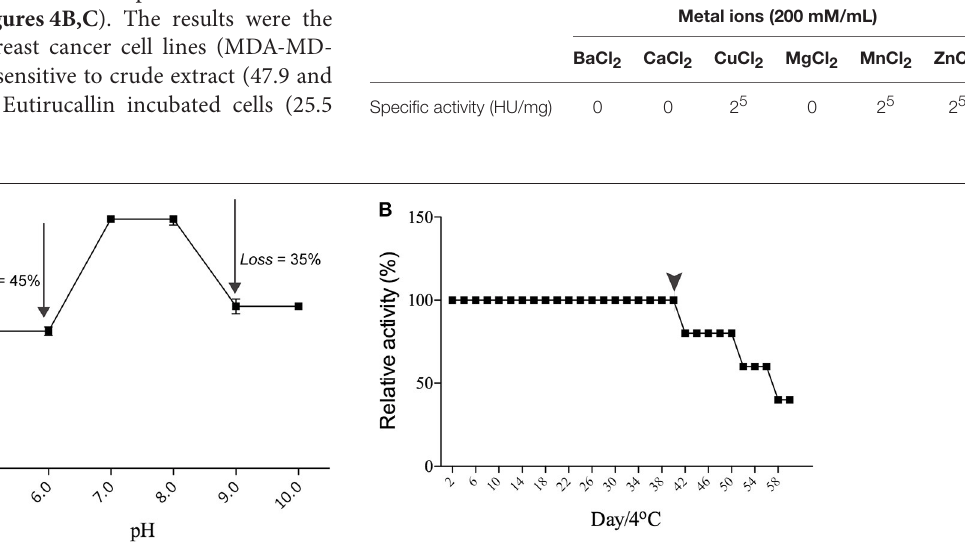
FIGURE 2 | Effects of pH (A) and stability (B) on the hemagglutinating activity of Eutirucallin using murine erythrocytes. Arrows indicated losses of hemagglutinating activity. Arrowheads indicate the threshold of hemagglutinating activity.